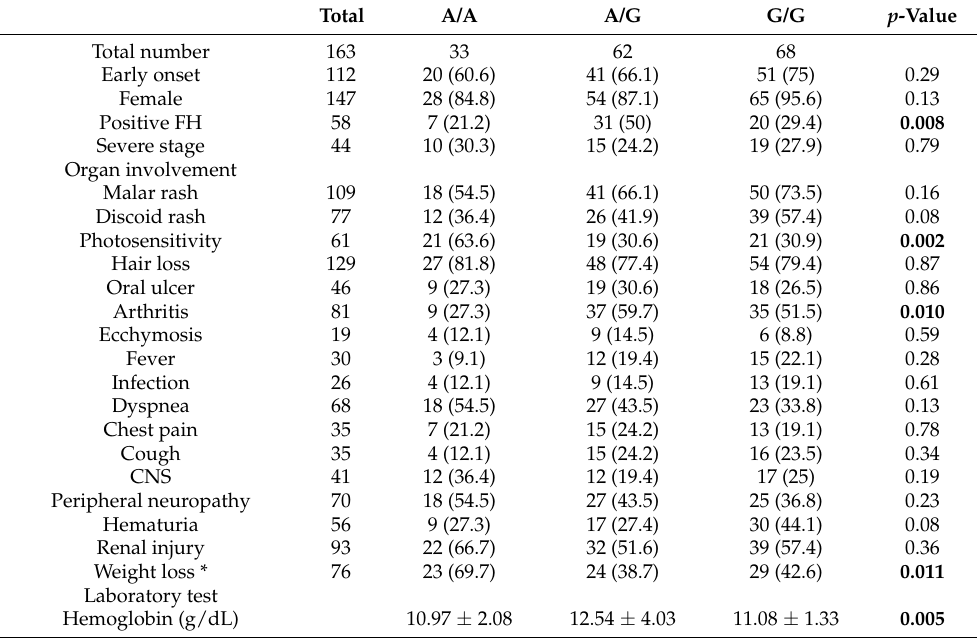
Table 5. Association between miR-34a rs2666433 (A/G) genotypes and the clinic-laboratory